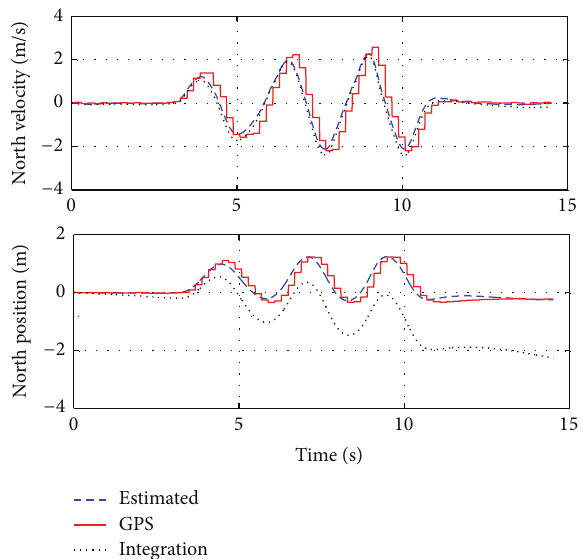
Figure 9: Comparison between the velocity and position derived from the proposed fusion algorithm, GPS, and acceleration integra- tion.